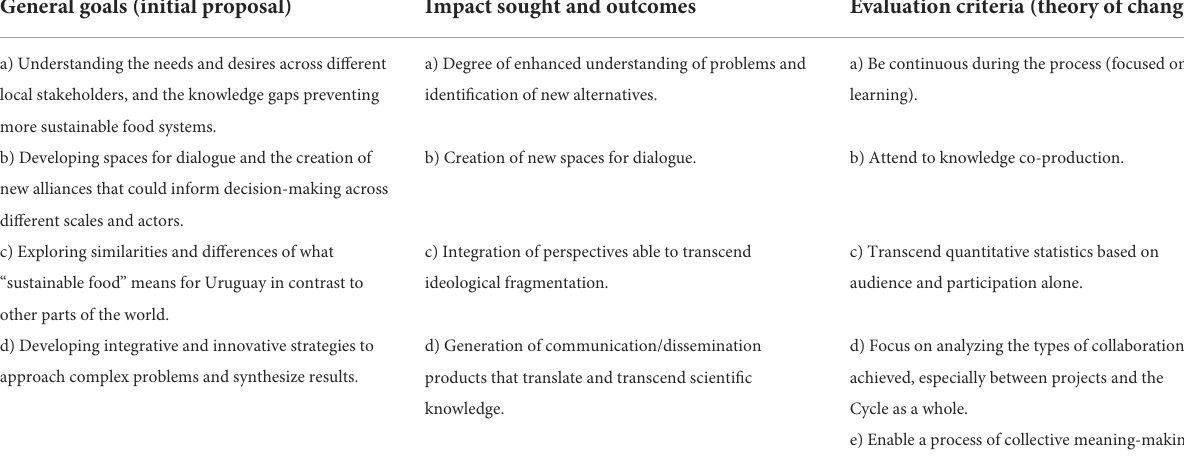
TABLE 5 Breakdown of goals, types of outcomes, and impact sought and our evaluation criteria. General goals (initial proposal) Impact sought and outcomes Evaluation criteria (theory of